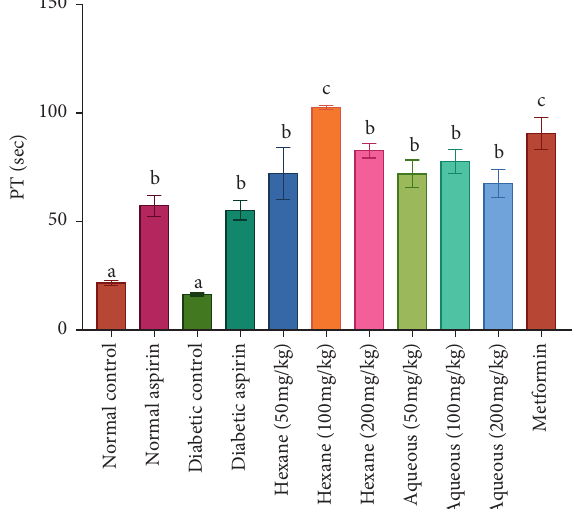
Figure 3: Prothrombin time (PT) in diabetic rat treated with different concentrations of aqueous and hexane fractions of C. crepidioides . Bars with different letters are significantly different ( n � 4); b is significantly higher than a ( P < 0 . 001). c is significantly higher than a ( P < 0 . 0001).